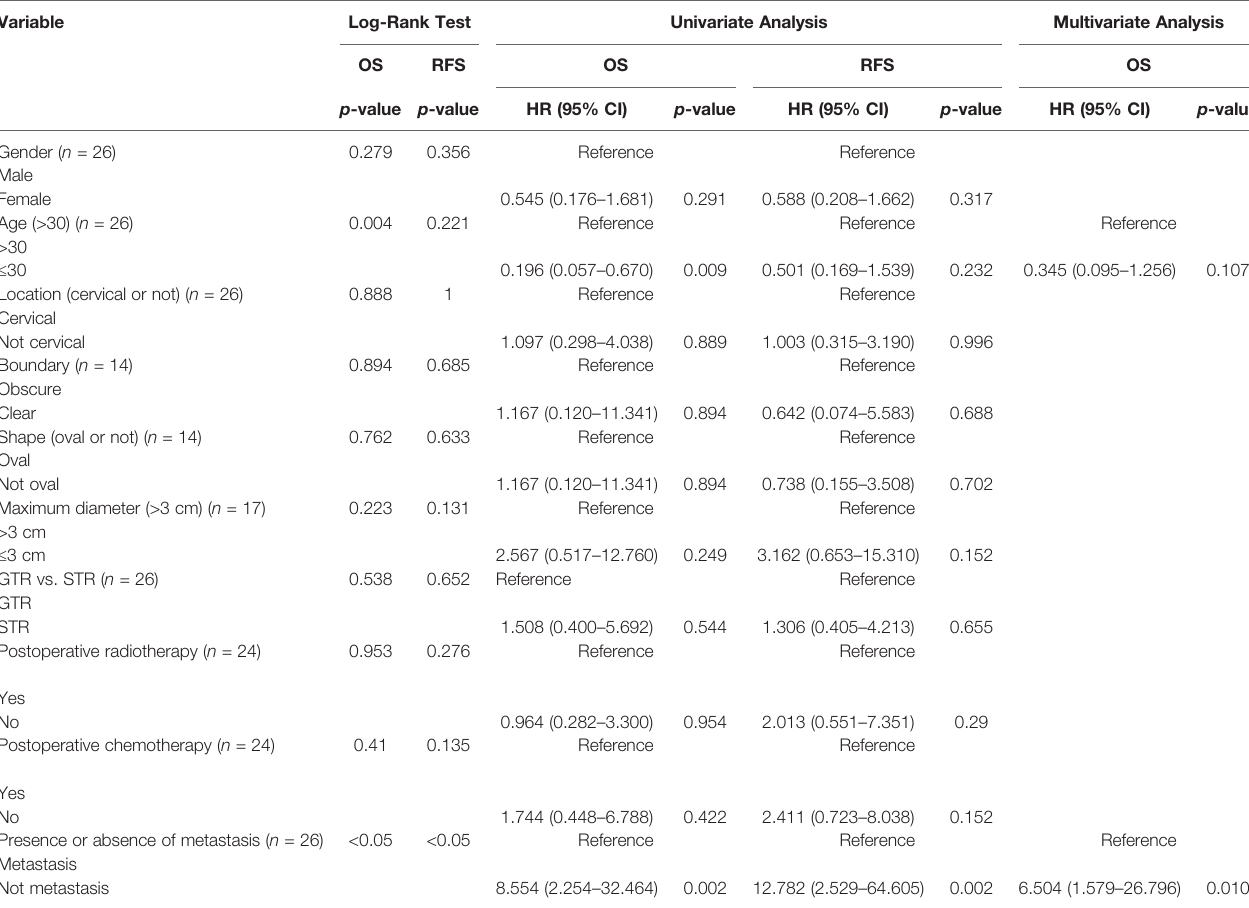
TABLE 5 | The results of the log-rank test, and univariate and multivariate Cox regression analysis. Variable